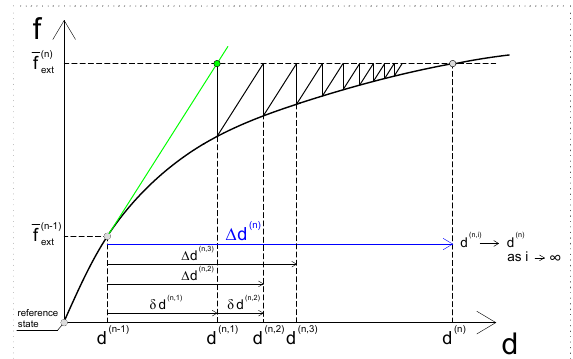
Figure 4. Initial stiffness